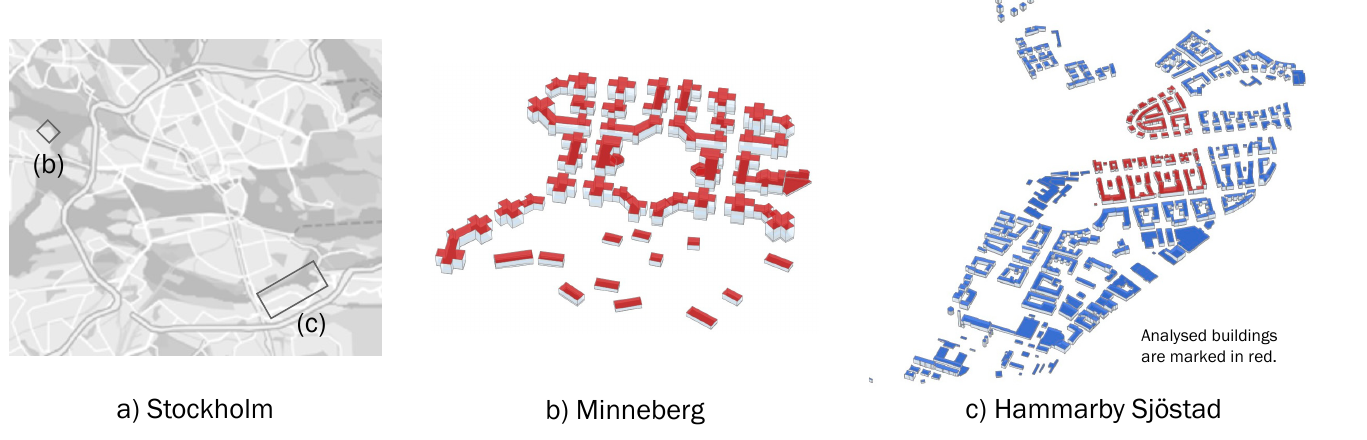
Figure 8. The two urban areas in Stockholm ( a ) considered in this study—( b ) Minneberg and ( c ) Hammarby Sjöstad. The buildings analysed are marked in red.